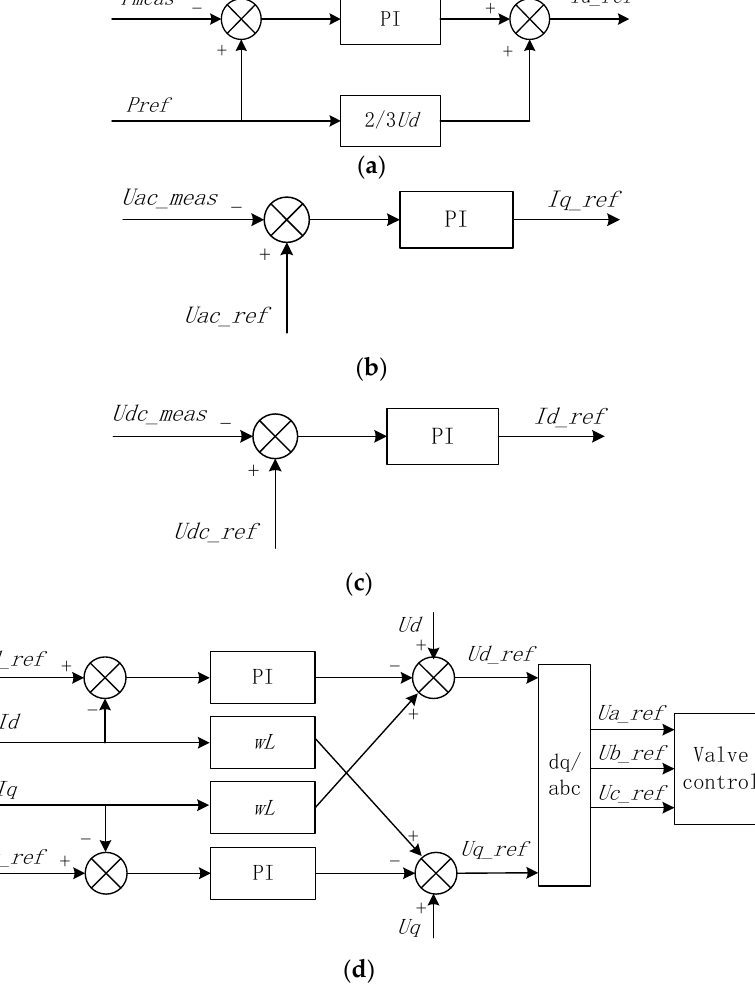
Figure 11. Control logic diagram; ( a ) constant active power control loop of outer loop; ( b ) constant AC voltage control loop of outer loop; ( c ) constant DC voltage control loop of outer loop; ( d ) current control loop of the inner loop.